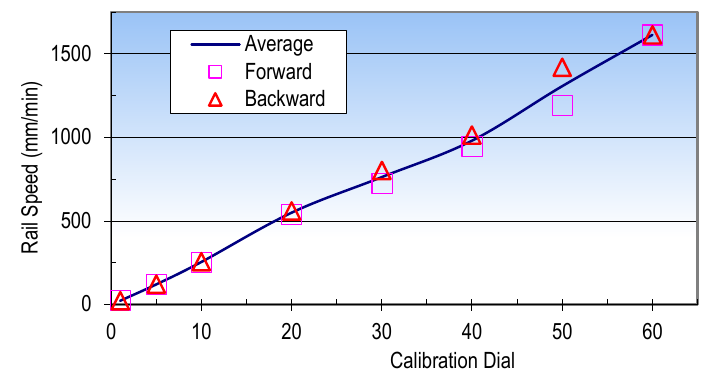
Figure 3: Calibration of rail speed (welding speed) for the Victor Mod 100